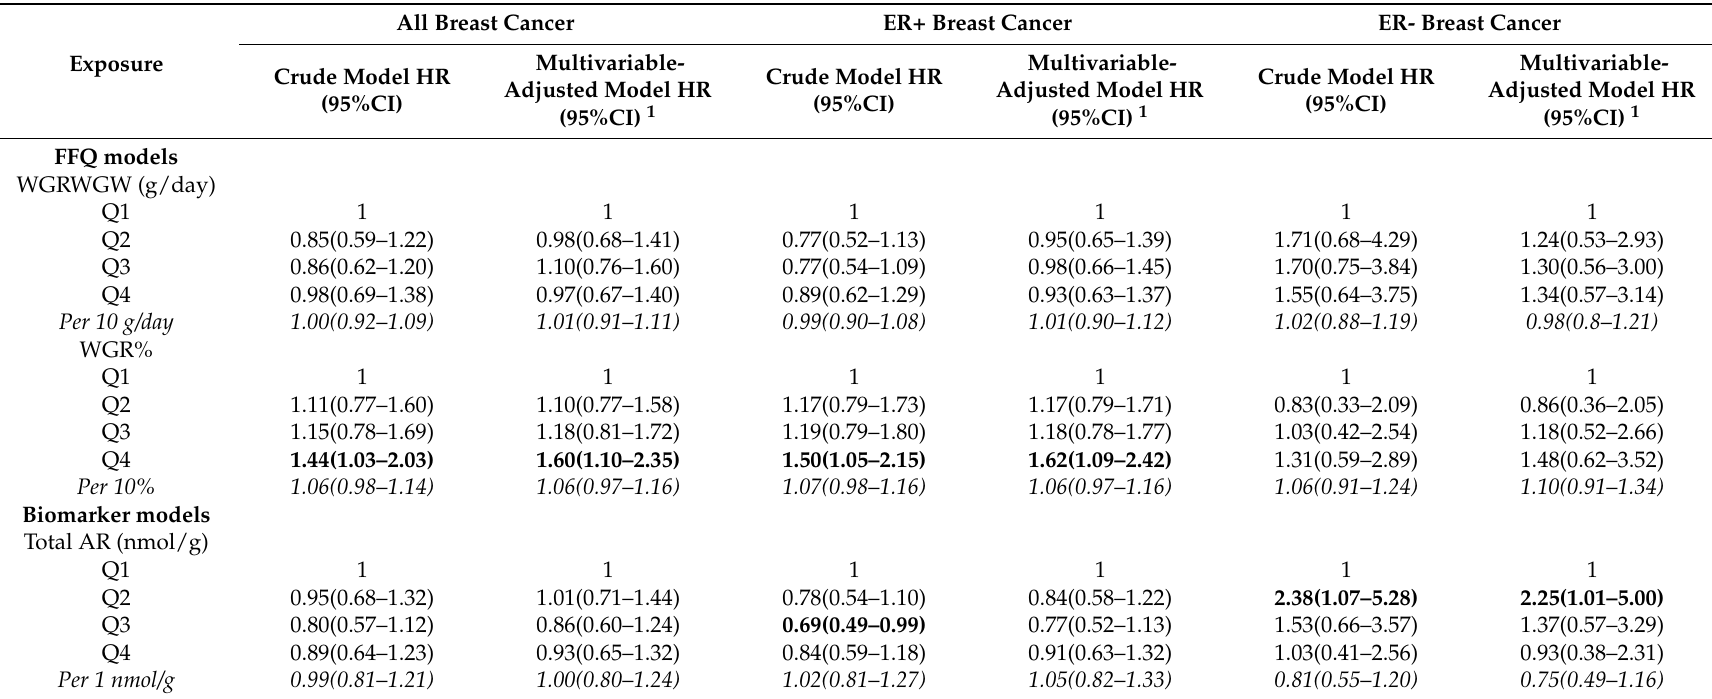
Table 2. Hazard ratio and 95% confidence interval of total, estrogen receptor-positive, and estrogen receptor-negative breast cancer across quartiles of total whole grain rye and wheat intake and relative whole grain rye intake estimated with a food frequency questionnaire and alkylresorcinol concentrations in adipose